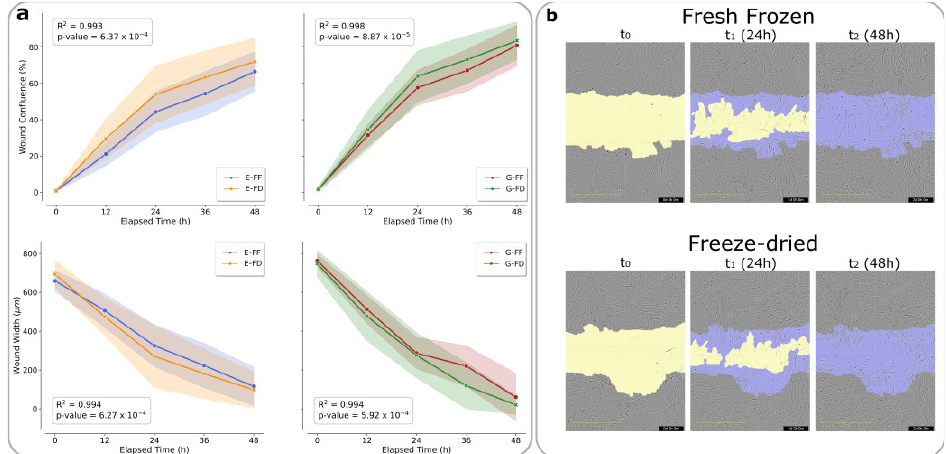
Figure 4. Analysis of the scratch wound on MIO-M1 treated with PRP-FF and PRP-FD ( a ) Graphical representation of the wound confluence and wound width of MIO-M1 cells treated with 5% PRP- FF and PRP-FD preparations added to the growth medium; E = sample E, and G = sample G. ( b ) Representative images of MIO-M1 cells recorded using the IncuCyte S3 instrument with a 10x objective lens at different treatment times with PRP-FF and PRP-FD (t 0 = at the scratch, left column; t 1 = 24 h, middle column; t 2 = 48 h, right column). Yellow: initial scratch wound area; purple: MIO-M1 cells that migrated into the wound area.